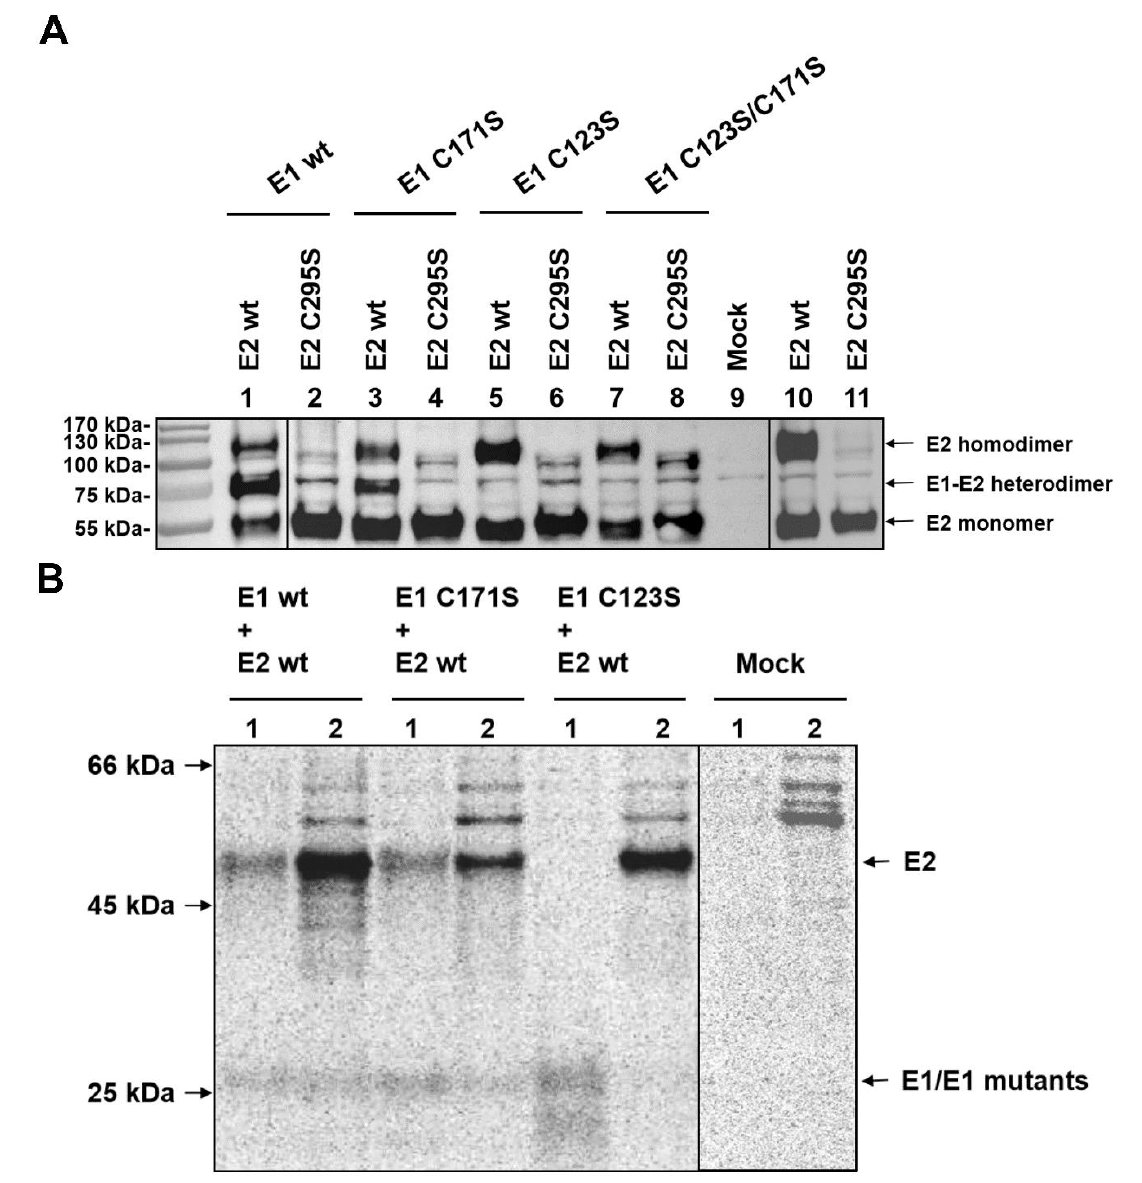
Figure 3. C123 in E1 is the critical residue for E1/E2 heterodimer formation; C295 in E2 is essential for not only E1/E2 heterodimerization but also for E2 homodimer formation. ( A ) The given HA-tagged E1 wt or cysteine lacking mutants were co-expressed with AU1-tagged E2 or E2 C295S mutant in RK-13 cells, and expression products were analyzed via Western blot on the following day. Cell lysates were prepared and separated by SDS-PAGE under nonreducing conditions. Western blot analysis was carried out using primary antibody α-AU1 and secondary antibody anti-rabbit-PO for the detection of protein. Above the gel, the composition of the samples is given. ( B ) E1 mutants containing single mutations (Cys to Ser) were also tested in this study. The E1 mutants C171S and C123S were co-expressed with E2 wt in RK-13 cells and analyzed via immunoprecipitation with either HA antiserum (lanes 1) or AU1 antiserum (lanes 2). The combinations of constructs transfected into the cells are given above the gel. A file is provided in the Supplementary Materials with the original Western blot results to demonstrate that the different parts presented here were derived from equivalent gels.